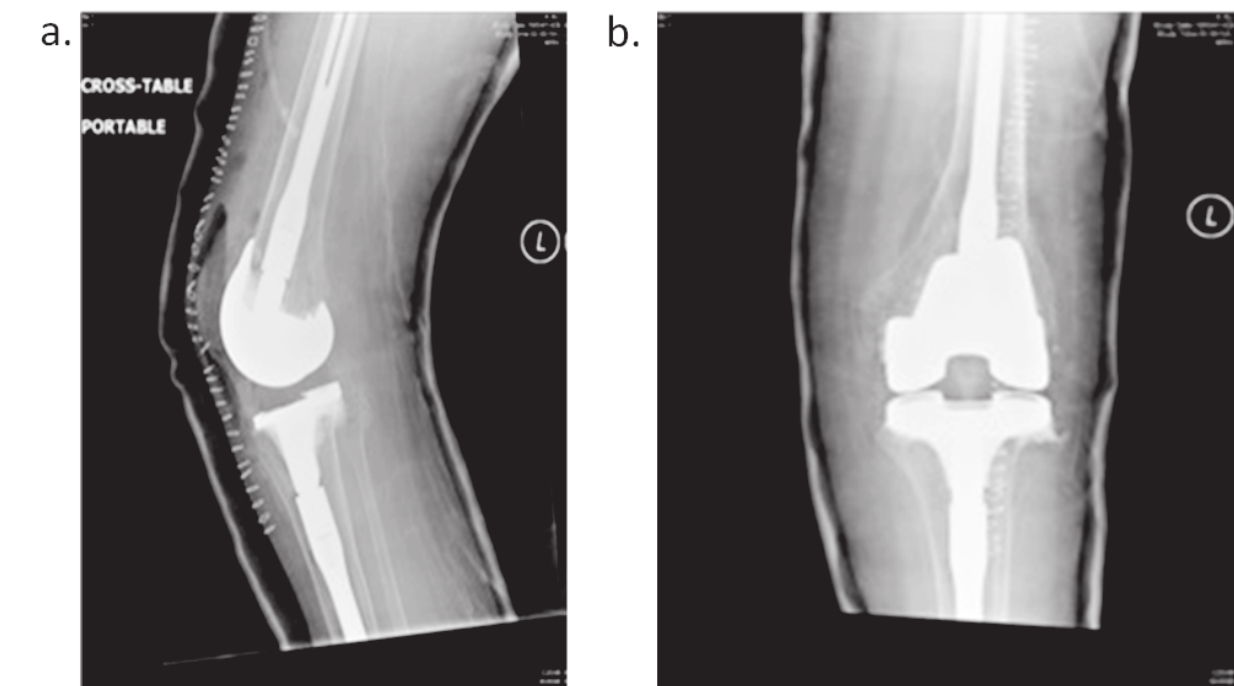
Figure 4. X-ray of left knee post